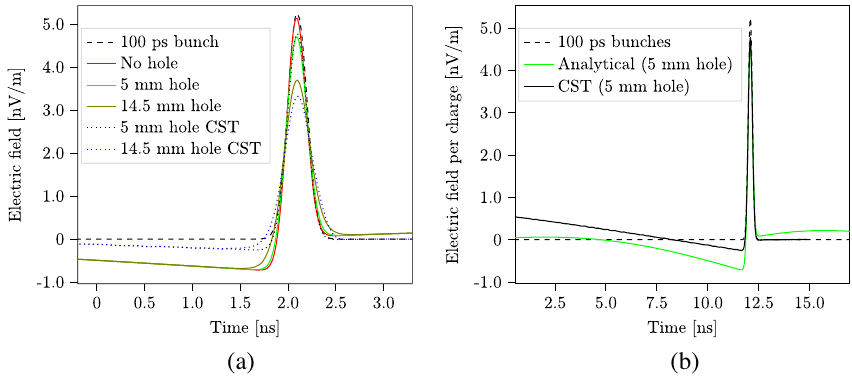
FIG. 14. (a) Obtained radiation (z component of E field) as a function of hole size for β ¼ 0 . 15 at monitor distance R ¼ 1 . 0 m at 85 degrees for an input of 100 ps σ bunch for different hole sizes. (b) Zoomed out view of the plot on the